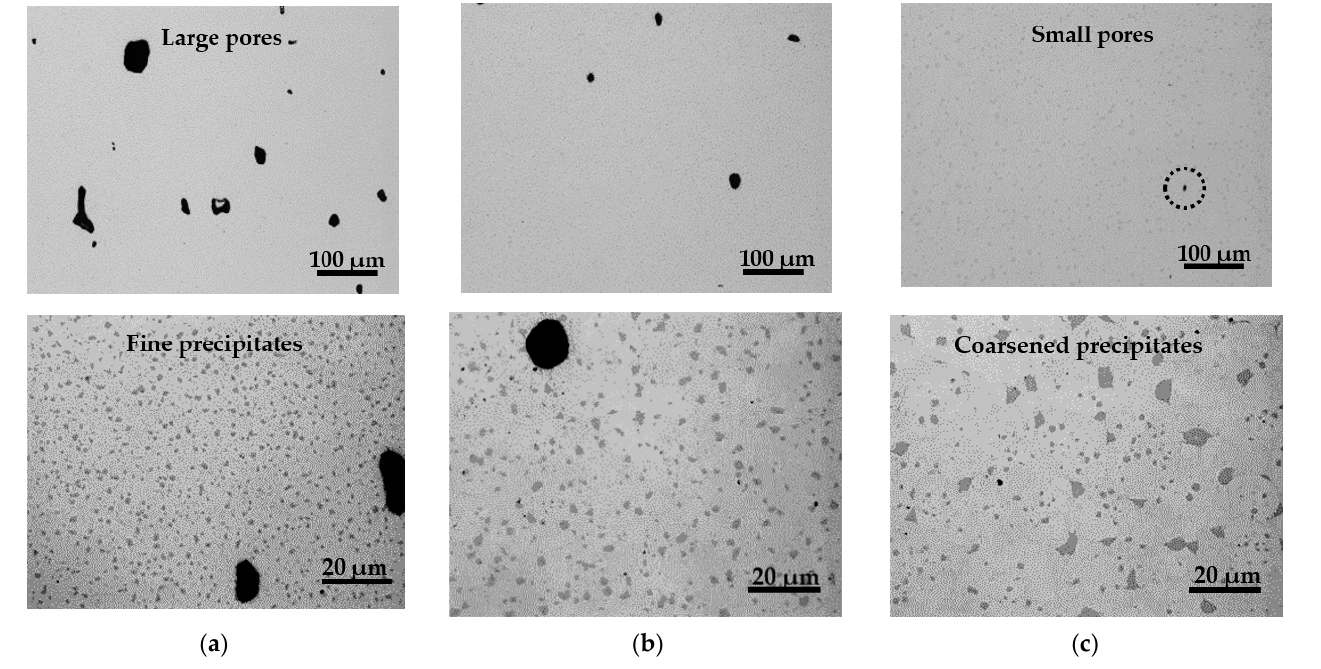
Figure 6. Changes in appearance of pores and precipitates with respect to sintering temperature. Panels ( a ) to ( c ) show that higher sintering temperatures correspond to fewer and smaller pores, but coarser precipitates. ( a ) Specimen B (1503 K); ( b ) specimen C (1513 K); ( c ) specimen D (1523 K).